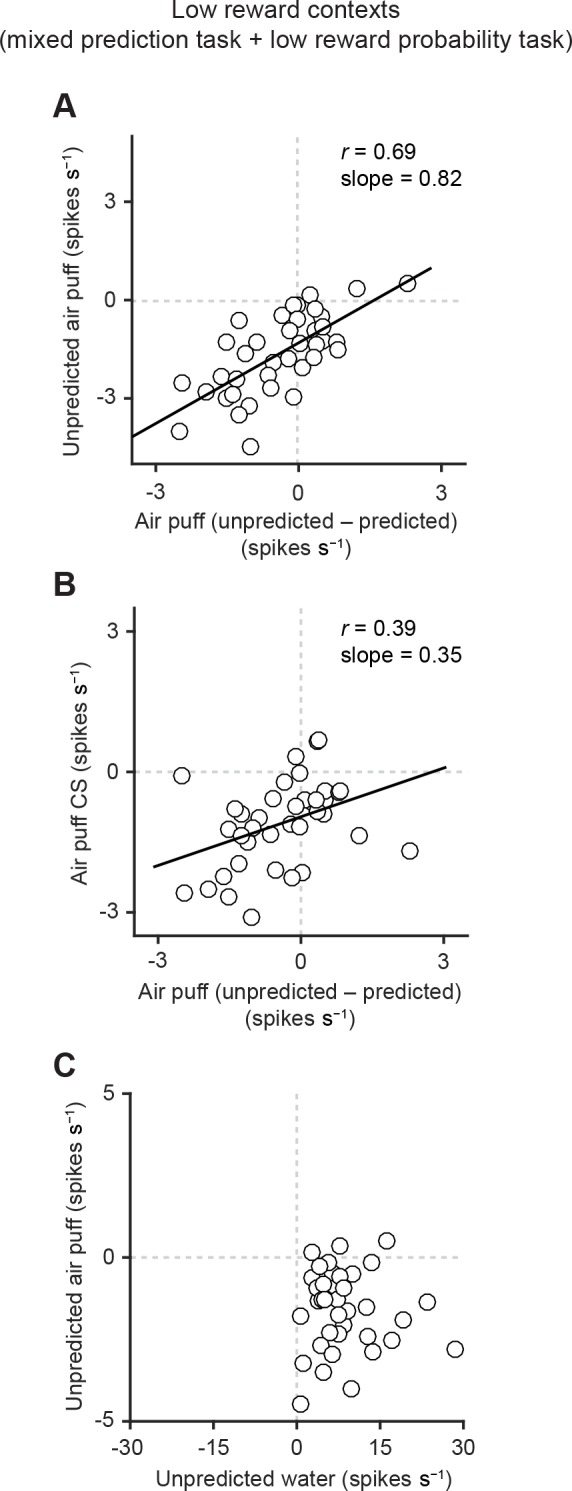
Correlation between responses related to aversive stimuli in dopamine neurons.(A) Scatter plot of the responses to unpredicted air puff (0–600 ms from air puff onset) and the effects of prediction on the responses to air puff US (subtraction of responses to unpredicted air puff from responses to predicted air puff, 0–600 ms from air puff onset) in dopamine neurons. Each data point represents an individual dopamine neuron (n = 38). The baseline firing rate (−1–0 s from odor onset) was subtracted for each neuron. Solid line, best-fit linear regression. Pearson’s correlation, r = 0.69, p=1.9 × 10−6. (B) Scatter plot of the responses to CS predicting air puff (0–1000 ms from odor onset) and the effects of prediction on the responses to air puff in dopamine neurons (n = 38). Pearson’s correlation, r = 0.39, p=0.016. (C) Scatter plot of the responses of individual dopamine neurons (n = 37) to unpredicted water and air puff (0–600 ms from water and air puff onsets, respectively). No correlation between these two responses (Pearson’s correlation, r = -0.04, p=0.834).